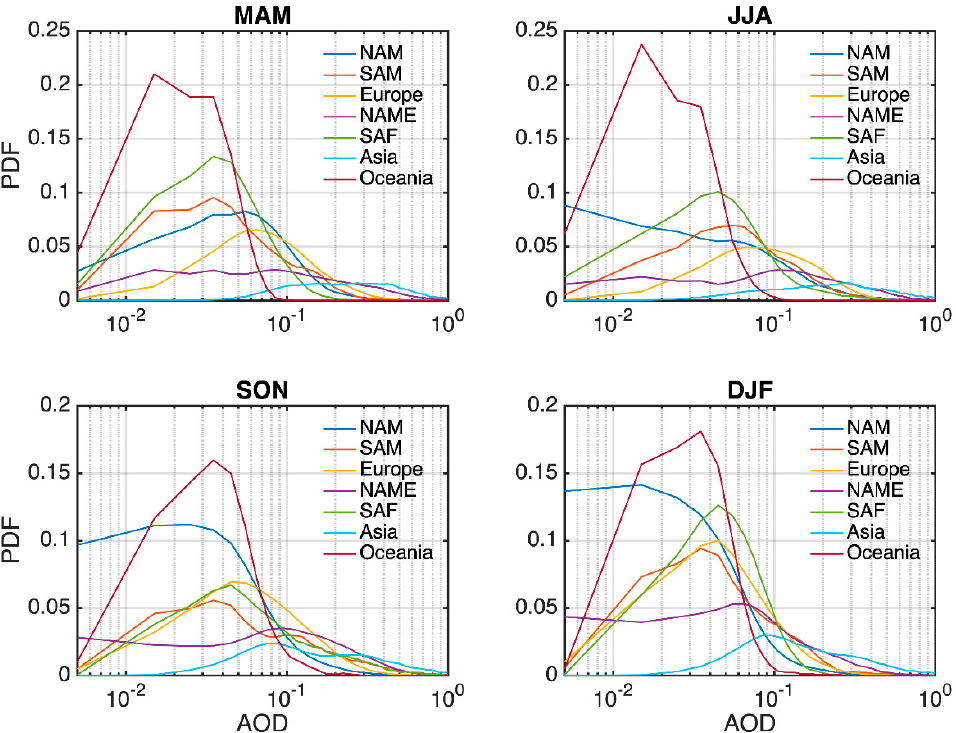
Figure 19. Probability density function of AERONET AOD for the four seasons over the seven regions.